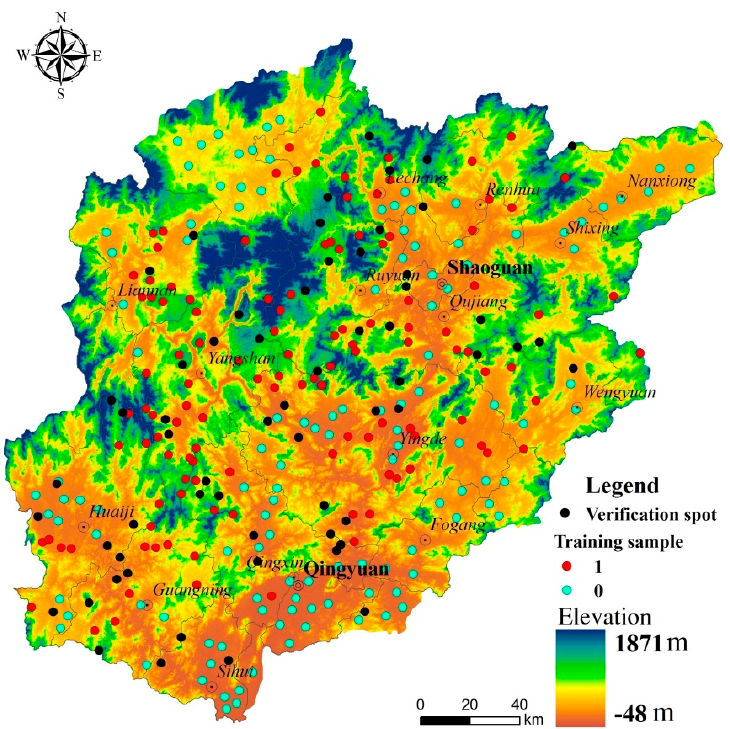
Figure 5. Location of landslide spots and training samples.